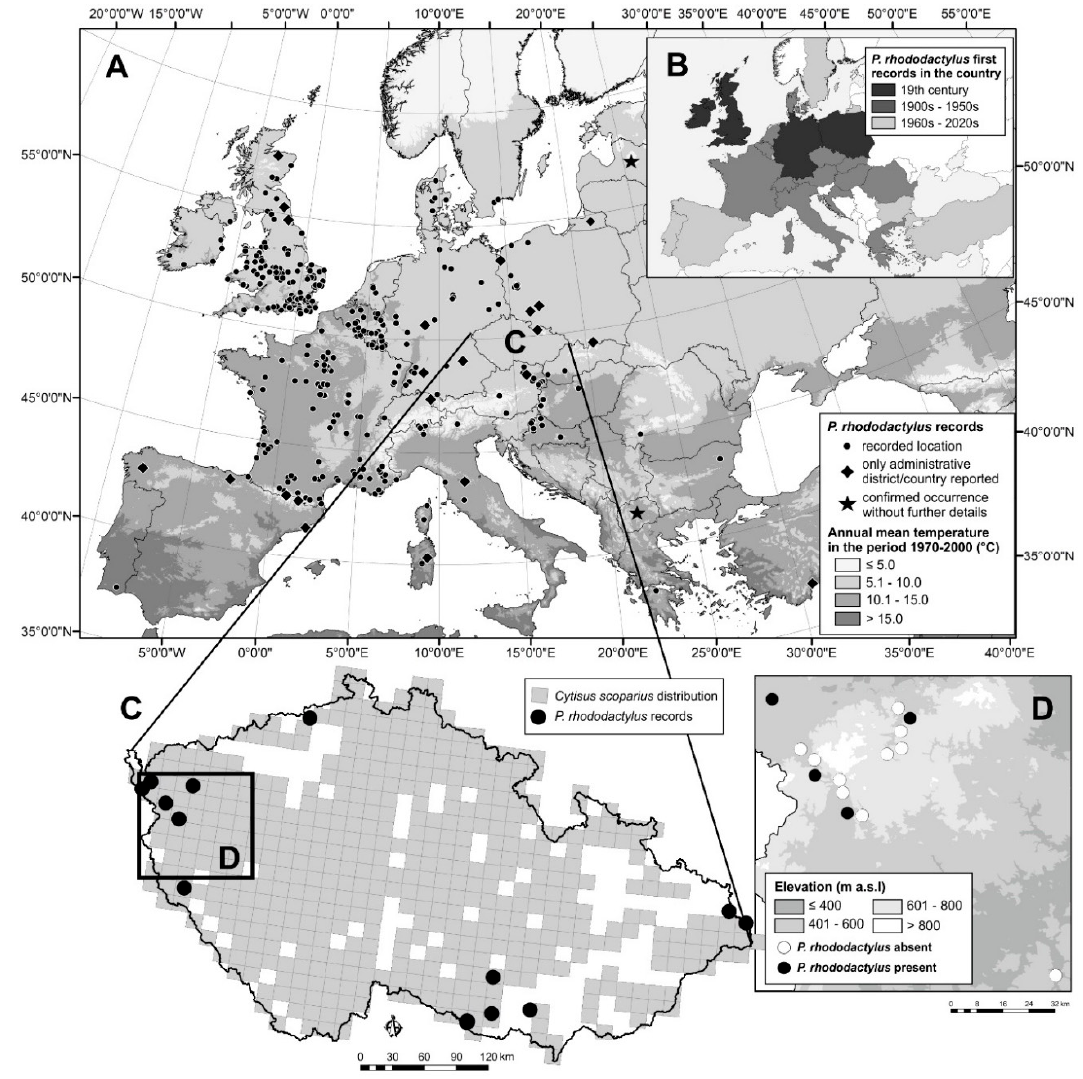
Figure 2. Localities (or countries and counties) where Phloeotribus rhododactylus has been reported to occur in Europe with annual mean temperature ( A ) (see Table 1); periods of its first reports in countries ( B ); occurrence of Phloeotribus rhododactylus with Cytisus scoparius in the Czech Republic (https: // portal.nature.cz / nd / ) (see Table 2) ( C , D ) in a recent study in western Bohemia, reported here (List of localities where Phloeotribus rhododactylus was not found in the study conducted by T. Fiala in 2020 in western Bohemia: Beˇcov na Teplou (50.0858942 N, 12.8625314 E); Blovice (49.5961411 N, 13.5222964 E); Doln í Žandov (50.0175272 N, 12.5845317 E); Doln í Žandov—Mansk ý dv˚ur (50.0356972 N, 12.5319819 E); Kfely (50.1607864 N, 12.8421089 E); Mari á nsk é L á znˇe (49.9555339 N, 12.6991647 E), NR Lazurov